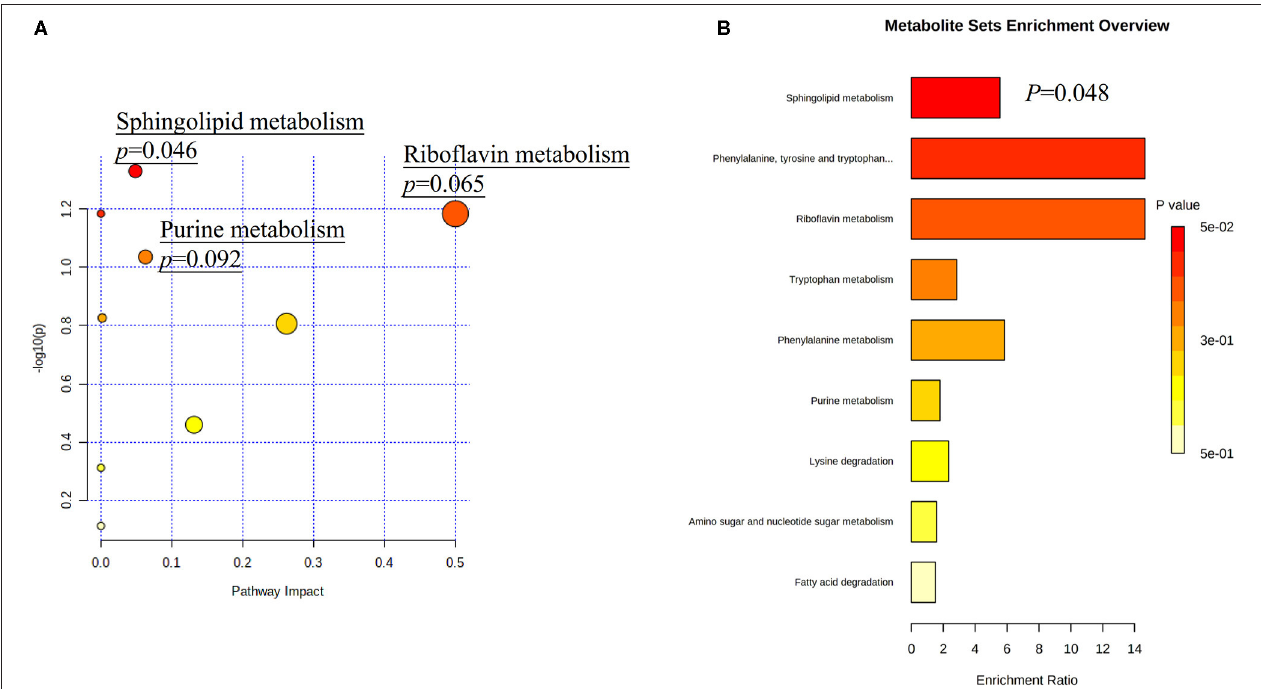
FIGURE 3 | Metabolic pathway analysis based on differentially expressed metabolites identified in the plasma of patients with GCC and PCC. (A) Kyoto Encyclopedia of Genes and Genomes metabolic pathways database showed that the sphingolipid metabolism is the only statistically significant pathway. The X -axis represents the pathway impact, and the Y -axis represents –log10 ( p ). (B) Metabolite set enrichment analysis showed that the sphingolipid metabolism is the statistically significant pathway based on differentially expressed metabolites identified in the plasma of patients with GCC and PCC. GCC, good collateral circulation; PCC, poor collateral